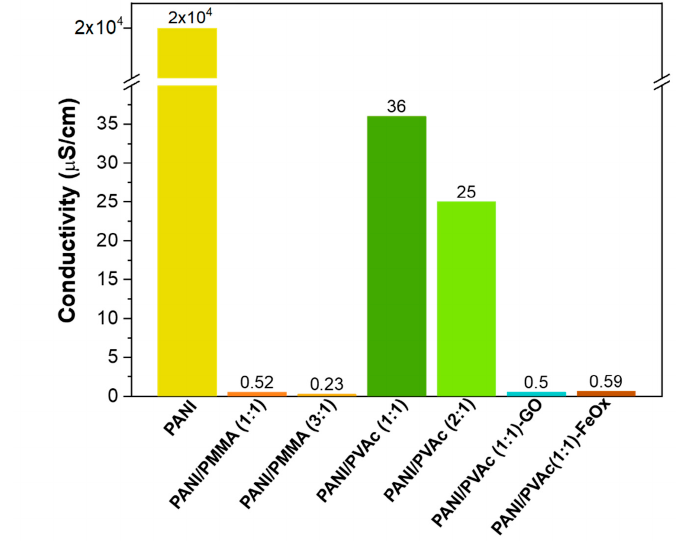
Figure 4. Electrical conductivity of as-electrospun mats.